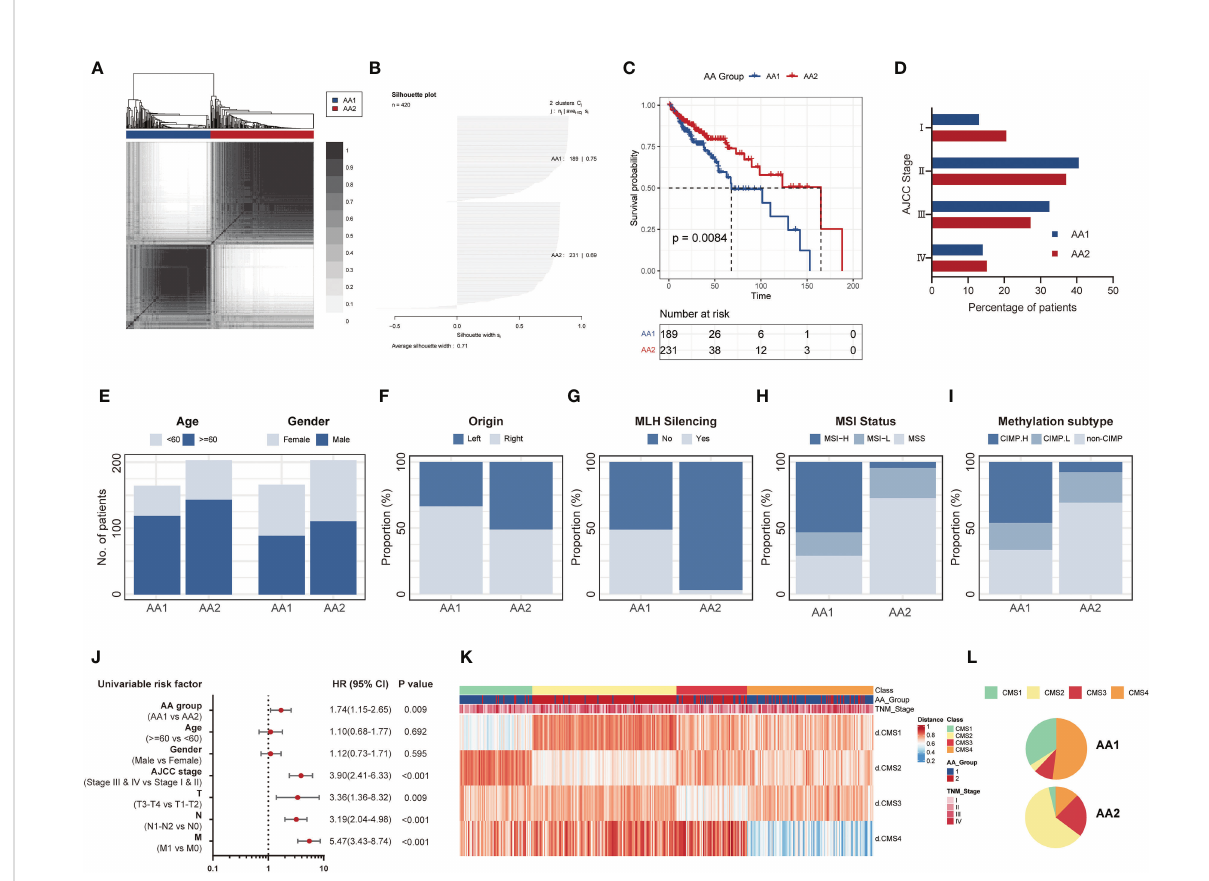
FIGURE 1 K-means consensus clustering identi fi es two metabolism subtypes in COAD. (A) Consensus clustering matrix heatmap and dendrogram for k=2 shows two distinct group patients based on the amino acid metabolism genes in the TCGA dataset. (B) Plot for silhouette width of 420 TCGA primary COAD patients indicating each object of the classi fi cation fi t into respective cluster well. (C) Overall survival of two AA subtypes in the TCGA cohort. (Log-rank test). (D) The percentage of patients with AJCC staging between AA subtypes. (E – I) The proportion of clinical characteristics including age and gender (E) , primary tumor location (F) , MLH silence rate (G) , MSI status (H) , and methylation subtype (I) between two AA subtypes. (Chi-square test). (J) Univariate analysis of AA group, age, gender, AJCC stage, and TNM stage in overall survival. Univariate Cox Proportional Model was used to estimate the hazard ratios. (K, L) The distribution of CMS subtypes in AA subtypes. COAD: colon adenocarcinoma, MLH: MutL Homolog 1, MSI: Microsatellite instability, CIMP, CpG island methylator phenotype; AJCC, American Joint Committee on Cancer; HR, hazard ratio; CMS, consensus molecular